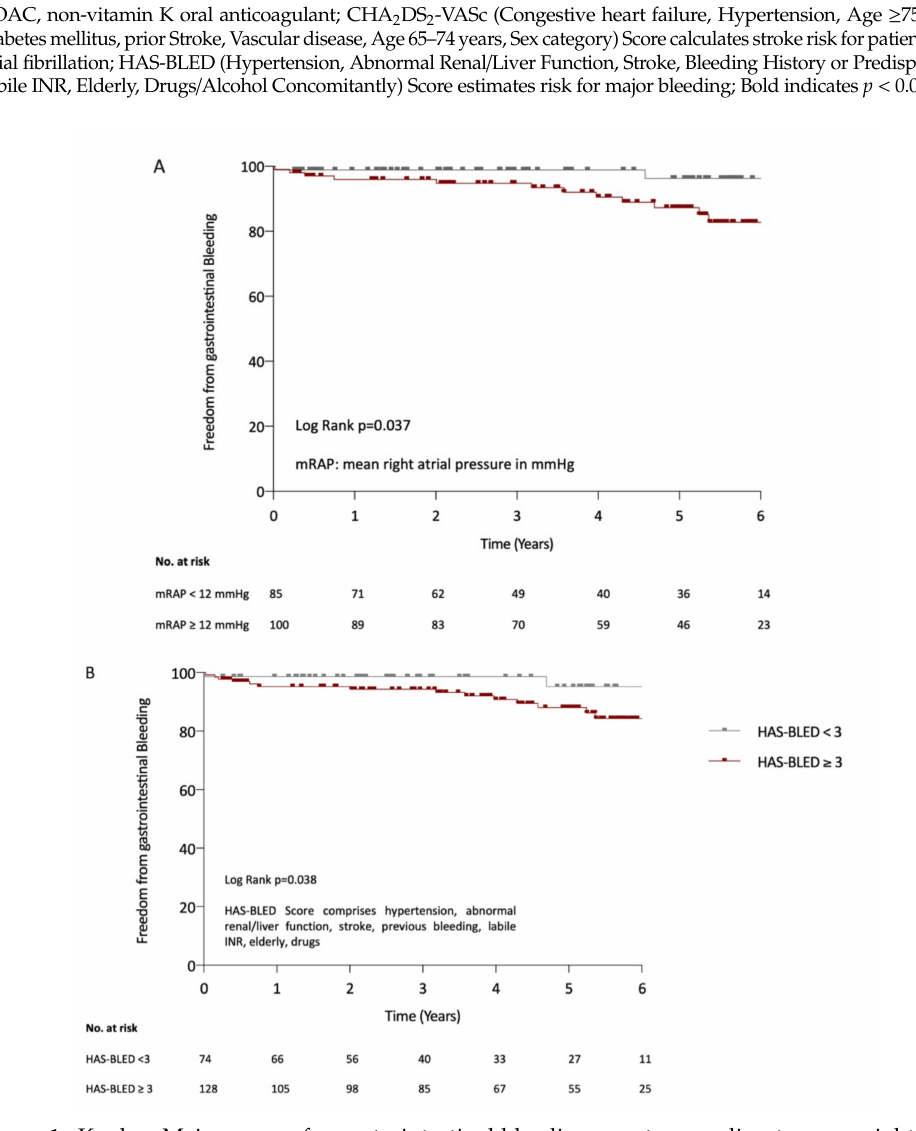
Figure 1. Kaplan–Meier curves for gastrointestinal bleeding events according to mean right atrial pressure (mRAP) ( A ) and the HAS-BLED score ( B